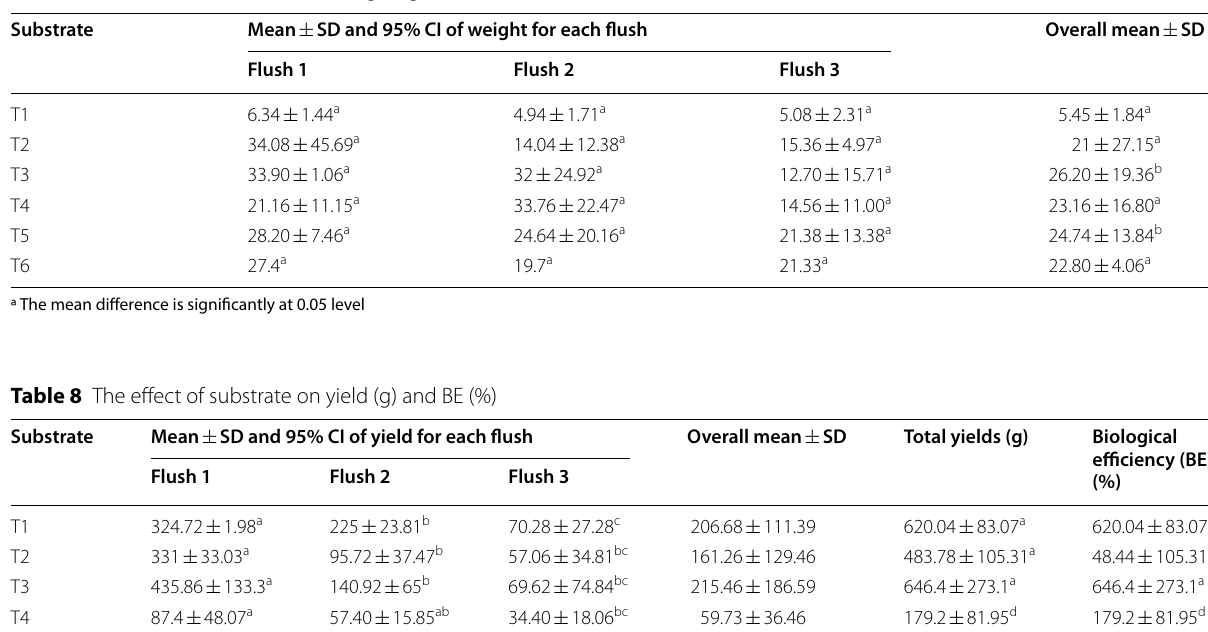
Table 7 The effect of substrates on weight (g) Substrate Mean